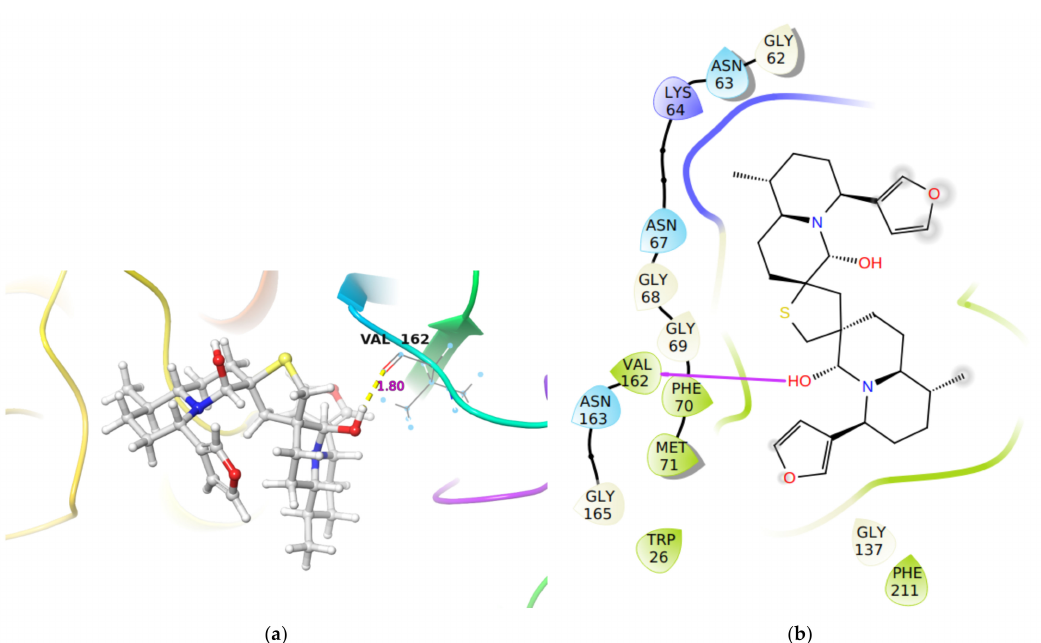
Figure 5. ( a ) 3-D representation of DTBN docked to Cathepsin S. H-bond interactions are displayed in yellow dotted lines, ( b ) 2-D Ligand interaction diagram of DTBN docked to Cathepsin